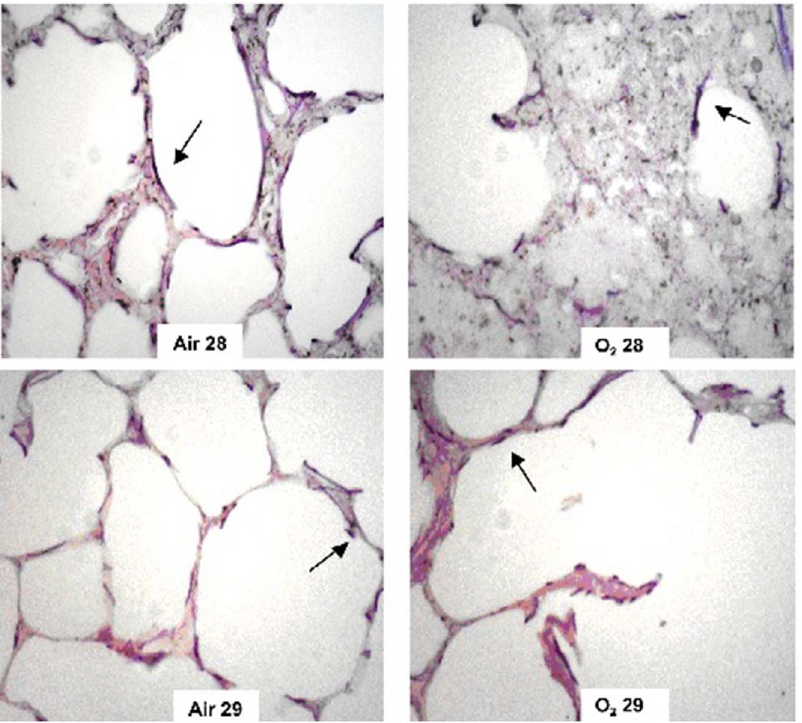
Figure 4. Distribution of elastic fibers (arrows) in the study groups. Oxygen exposed animals (right panels, upper and lower) showed an intense disorganization of elastic fibers compared to animals from the Air 28 and Air 29 group (left panels, upper and lower).